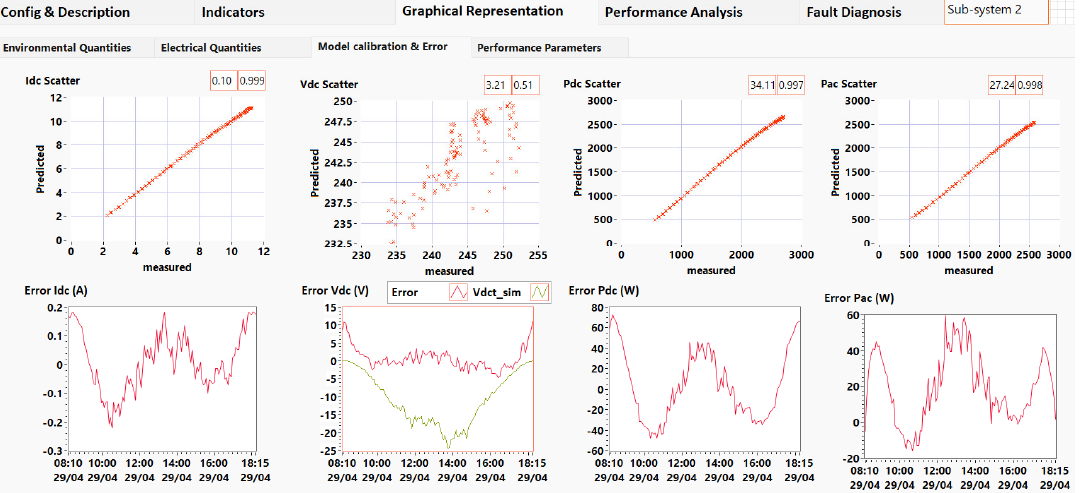
Figure 18. Modeling interface -tab for models’ calibration.